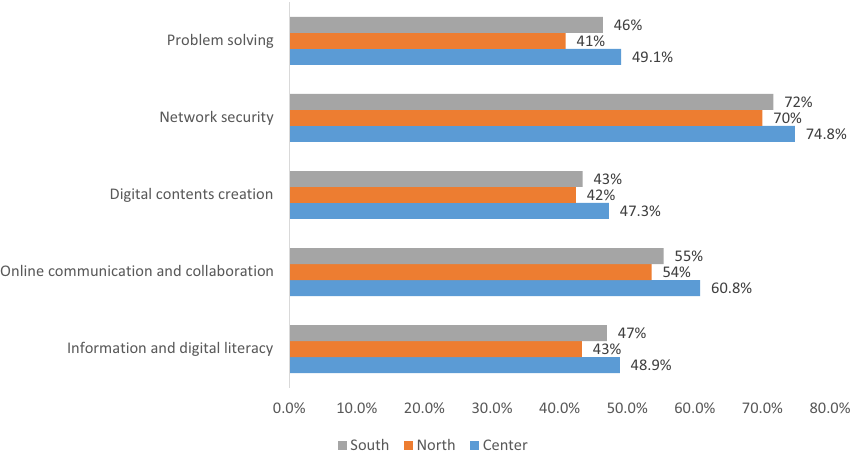
Fig. 5 Level of achievement in the areas of digital competence by type of